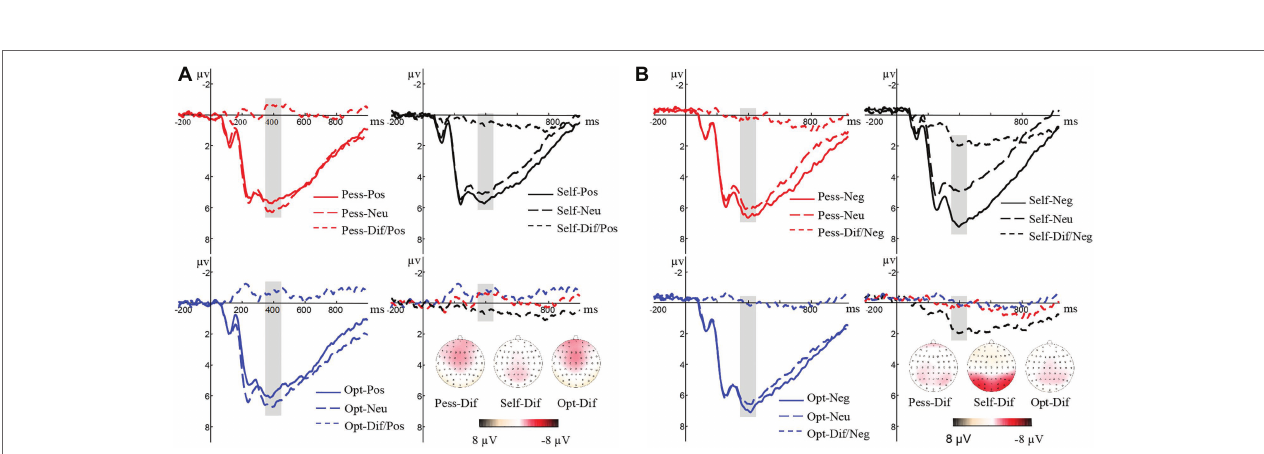
FIGURE 3 | (A) Original and difference waves of P3 using average values of Pz, P3, and P4 under positive picture judgment conditions. (B) Original and difference waves of P3 using average values of Pz, P3, and P4 under negative picture judgment